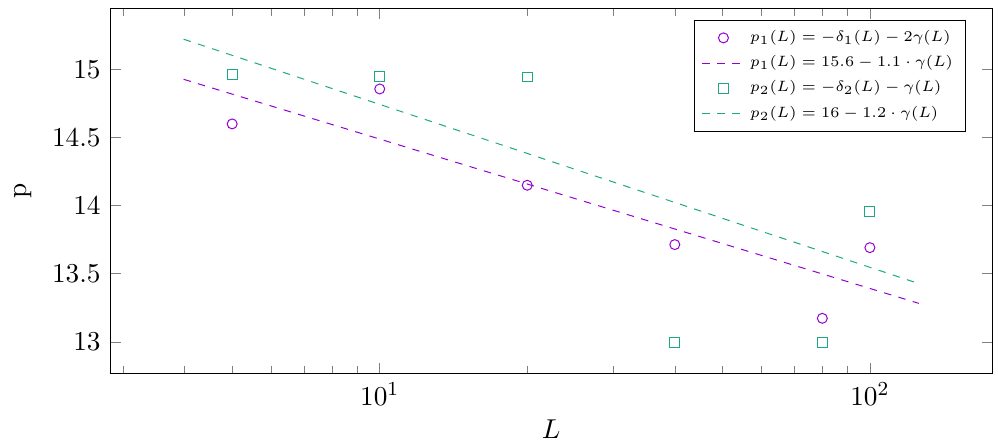
Figure 11: Numerical precision calculated from eq. (38) for graph representations Λ ( var ( ˆ H )) evaluated for various lattice sizes. The dashed lines are linear fits that 1,2 Heisenberg illustrate the average dependence on the lattice size of the contribution p numerical precision in the tensor-network contractions, p ( L ) = p short, Hubig et al. present a scheme to build MPO representations numerically via in-code evaluation of direct sums and Kronecker products of local operator strings acting on individ- ual lattice sites. To account for the growth in the MPO bond dimension, they discuss vari- ous numerical compression schemes and benchmark the obtained MPOs for a 100-site S = 1 Heisenberg chain. This scheme is somewhat more straightforward, as it only involves elemen- tary matrix